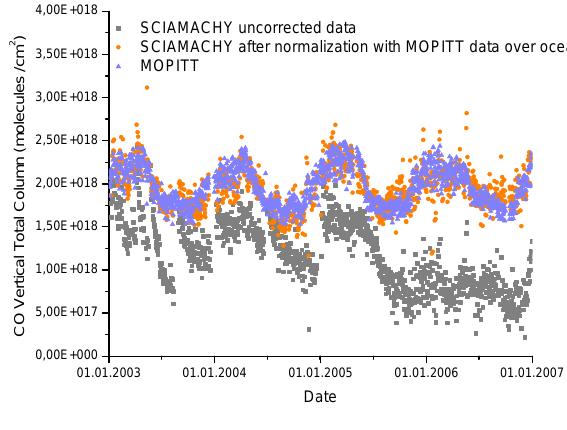
Fig. 1 Comparison between MOPITT CO VCDs and SCIAMACHY CO VCDs averaged over Sahara (20°N to 28°N; 8°W to 28°E) for each day in the period 2003 to 2006 with and without applying MOPITT normalization to the SCIAMACHY CO VCDs. The jumps of the uncorrected data in 2003 and 2004 are related to several ice decontamination phases. The reason for the drop in summer 2005 is not completely clear, but might be related to a broadening of the effective slit function (Liu, 2010).